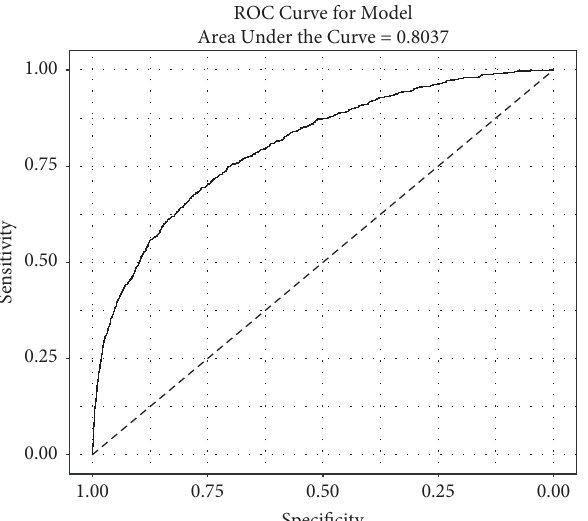
Figure 3: Te receiver operator characteristic curve for the logistic model. Te C-statistic is 0.8037. Abbreviations: ROC � receiver operator